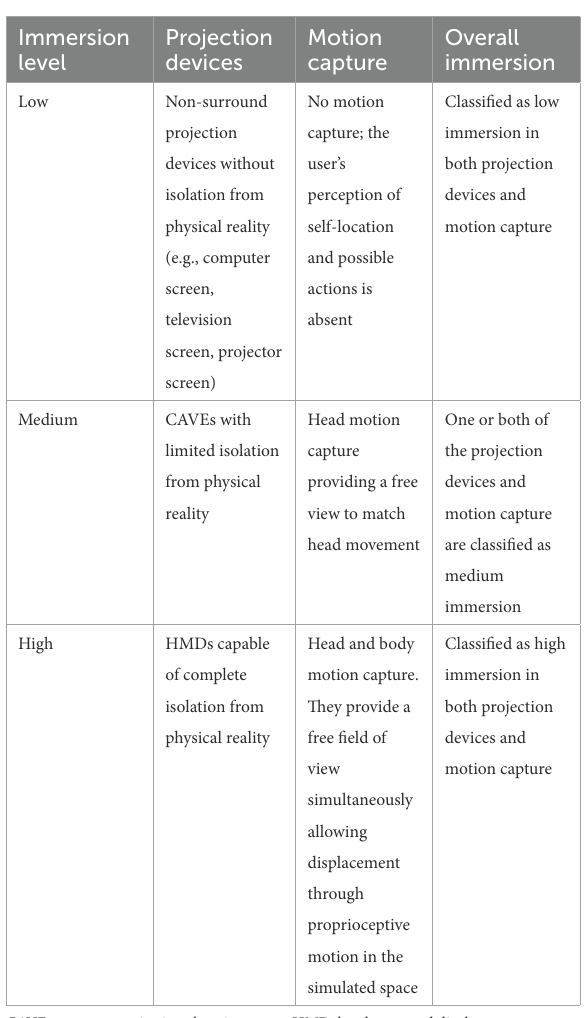
TABLE 1 Criteria of immersion